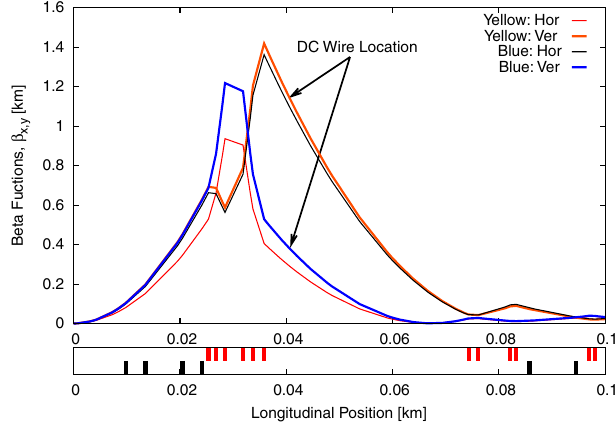
FIG. 9. The beta functions from MAD lattice for both rings as a function of longitudinal position.